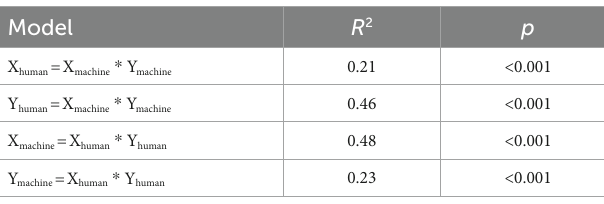
Each model predicts the coordinates of drawings along a given dimension in the human- or machine-derived embedding from both coordinates and their interaction in the other space. X and Y indicate the first and second dimensions of the human- or machine-derived